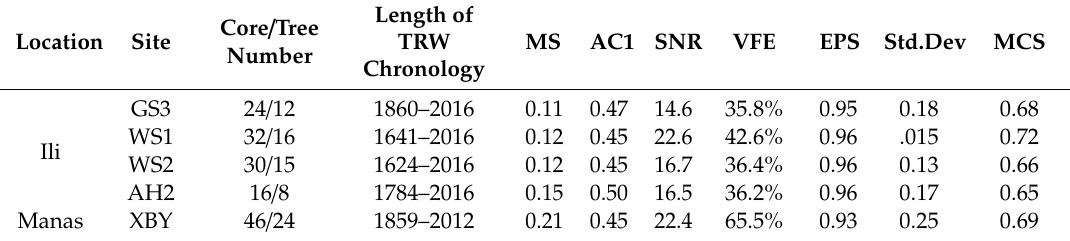
Table 3. Summary statistics for site tree-ring width (TRW) chronologies used in this study.